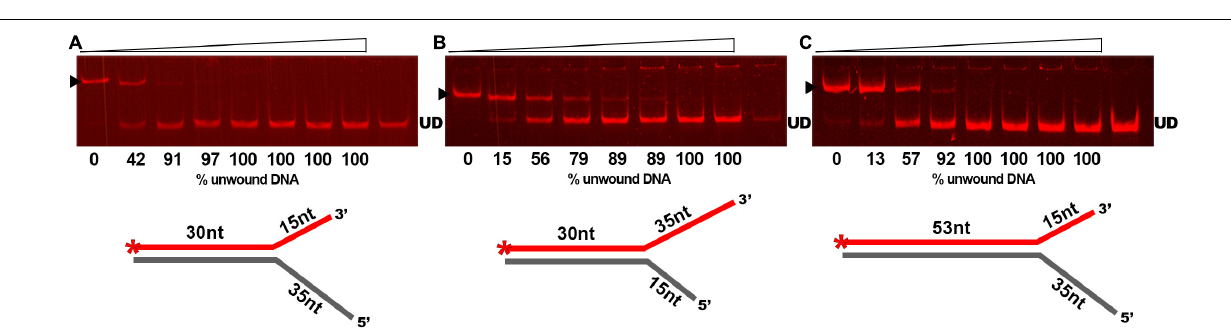
FIGURE 5 | Substrate specific unwinding by GP46 F 13 . Reactions with forked DNA substrates: (A) 30duplex_5 (cid:48) ext; (B) 30duplex_3 (cid:48) ext; (C) 53duplex_5 (cid:48) ext. Rising concentrations of the GP46 F 13 protein (0, 0.1, 0.25, 0.5, 0.75, 1,0, 1.5, 2.0 µ M) were incubated with specific branched substrate (1.5 nM) for 30 min at 30 ◦ C in reaction buffer (50 mM Tris-HCl, pH 8, 50 mM NaCl, 5 mM MgCl 2 ) and 5 mM ATP. Reaction samples were analyzed on native 15% polyacrylamide gels. (cid:73) indicates the expected migration of the substrate; UD indicates the expected migration of the unwound DNA (Cy5-labeled oligonucleotide) marked on the scheme in red and with an asterisk. but not with a 3 (cid:48) overhang (30duplex_3 (cid:48) ss), indicative of a 5 (cid:48) –3